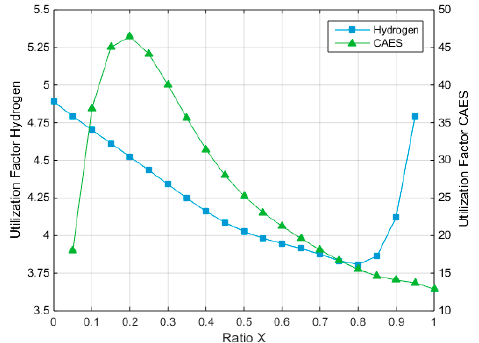
Figure 13. Comparison of the utilization factors for the two types of energy stores. In contrast, the utilization factor of the CAES store (right axis) goes from 12.8 up to 46.5 depending on the value of X . At a ratio X = 0.5, the utilization factor of CAES is 25.2 while the utilization of H 2 is only 4. The large utilization factors of CAES are owed to the frequency of its work cycles (i.e., how often the store is charged and discharged). A high- frequency profile allows a greater amount of energy to pass through storage in a given period of time.